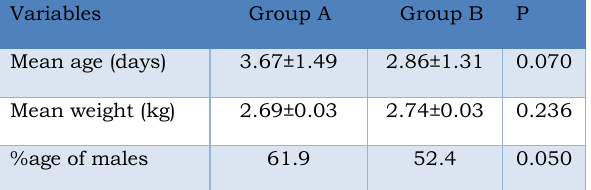
Table 1: Demographic details of the patients of two groups Variables